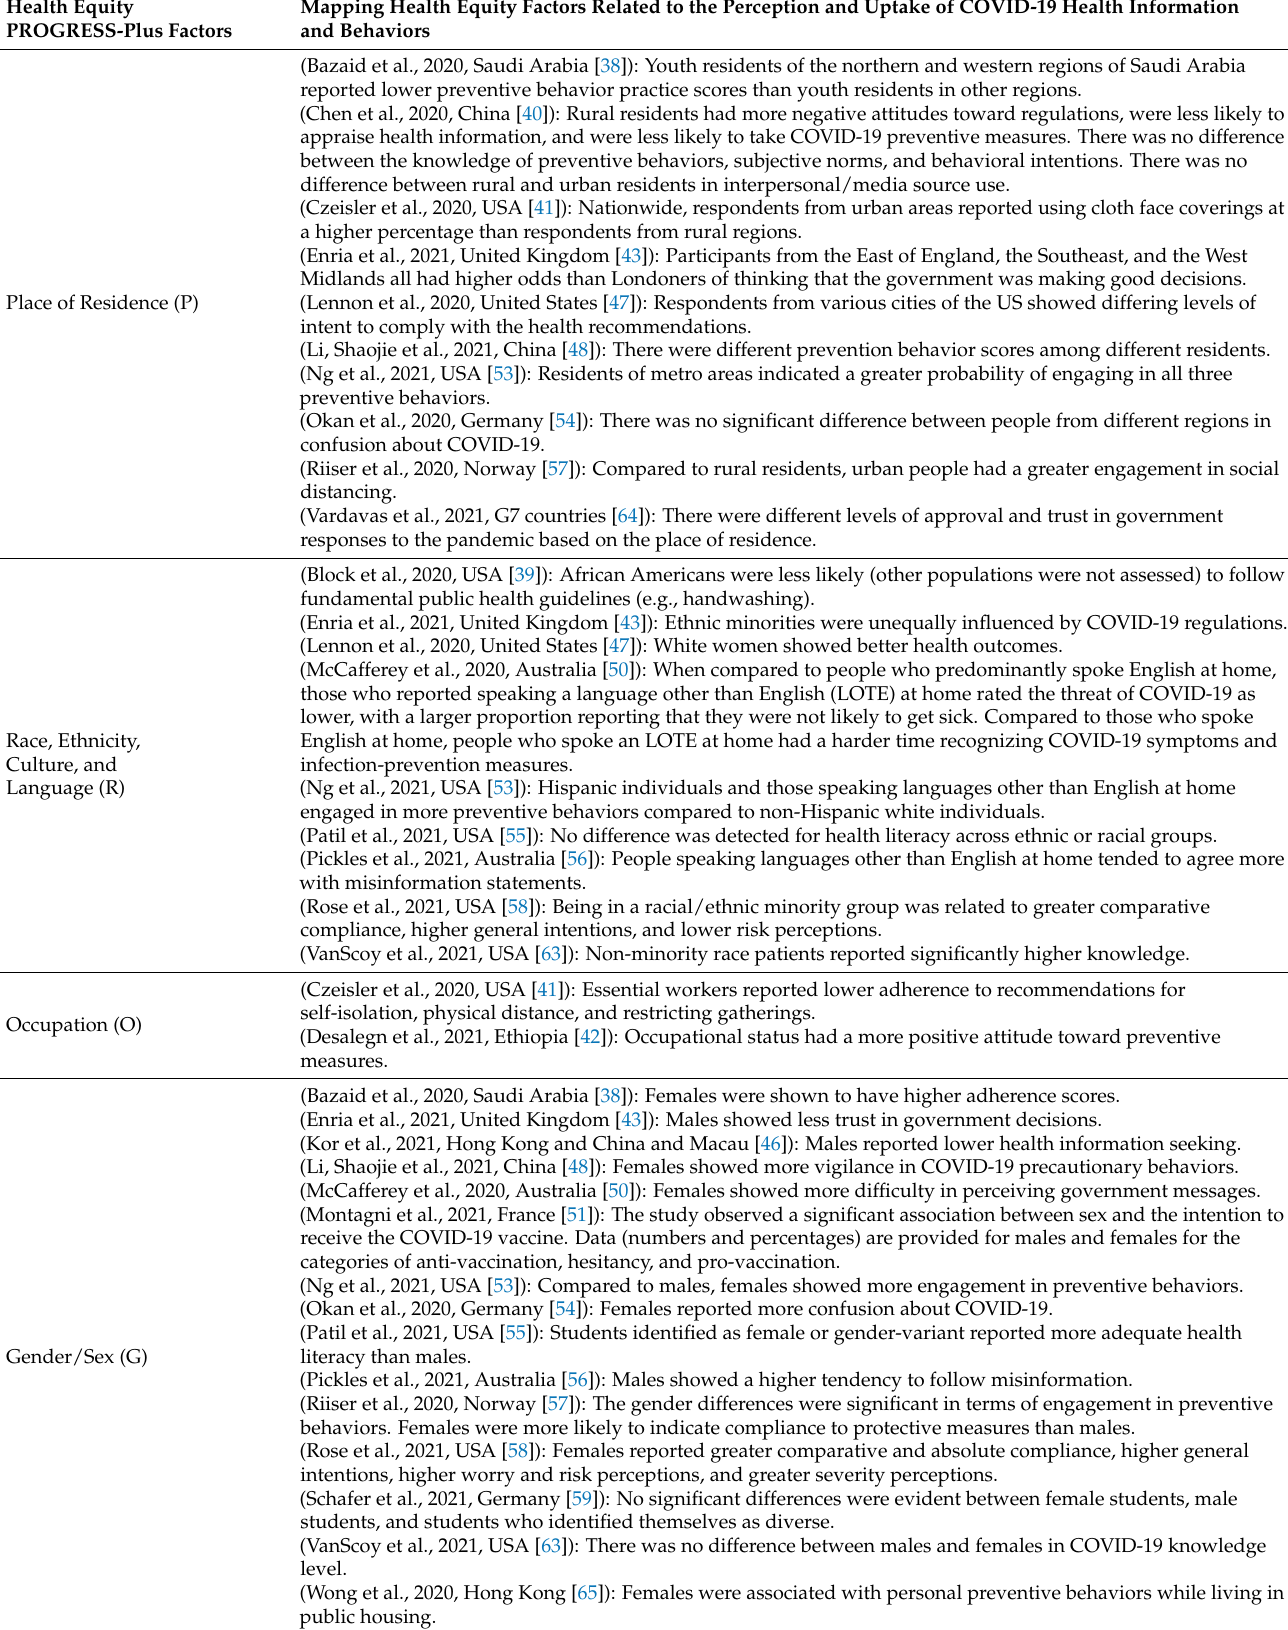
Table 3. Mapping PROGRESS-Plus health equity factors on perception and uptake of health